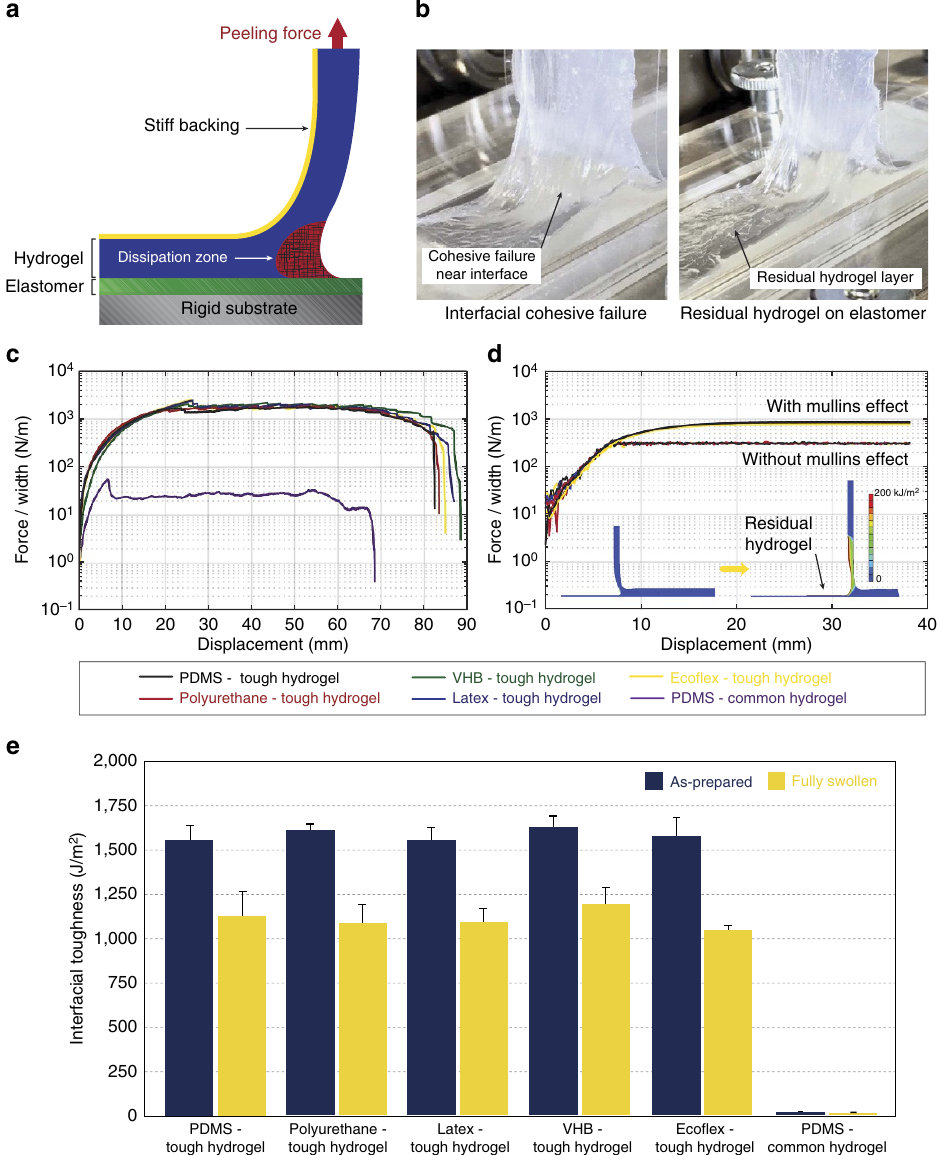
Figure 2 | Experimental and simulation results of 90 (cid:2) -peeling tests on hydrogel–elastomer hybrids. ( a ) Schematic illustration of the 90 (cid:2) -peeling test (ASTM D 2861) on various hydrogel–elastomer hybrids. A stiff backing is introduced to prevent elongation of hydrogel sheet along the peeling direction. ( b ) Photos of the hydrogel–elastomer interface during peeling test. The tough hydrogel undergoes a cohesive failure during the peeling test, leaving a thin residual layer of hydrogel B 0.2mm on the elastomer substrates. ( c ) The measured peeling forces per width of the hydrogel sheets for various hydrogel– elastomer hybrids (in as-prepared state). ( d ) The calculated peeling forces per width of the hydrogel sheets for various hydrogel–elastomer hybrids in finite-element simulation. The simulated interfacial toughness is significantly decreased as dissipative properties is eliminated in the hydrogel (that is, without Mullins effect) while maintaining other parameters the same. Note that inset pictures are snapshots of the 90 (cid:2) -peeling simulation. The contours indicate the energy dissipation per unit area in the material. ( e ) Summary of measured interfacial toughness of various hydrogel–elastomer hybrids using the proposed method at both as-prepared and fully swollen states. Values in e represent mean and the error bars represent the s.d. of measured interfacial toughness for each elastomer materials ( n ¼